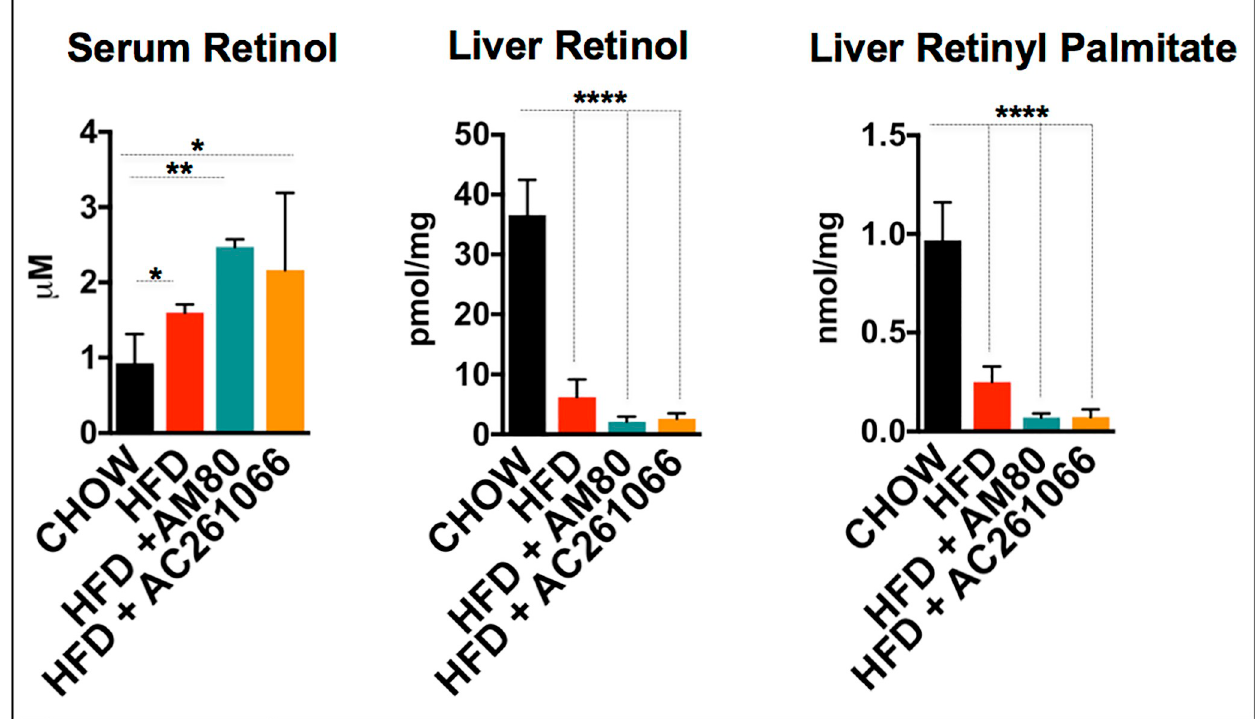
Fig 2. Retinol (ROL) is increased in serum, and retinol and retinyl palmitate are decreased in HFD-, HFD+AM80- and HFD+AC261066-treated compared to chow-fed mice. Quantitation by HPLC of serum retinol, liver retinol, and liver retinyl palmitate in chow-, HFD-, HFD+AM80-, and HFD +AC261066-treated mice. The plots are represented as mean ± standard deviation (SD). Mice per group = 4; Black stars represent statistical significance according to the one-way ANOVA test, p < 0.05 = � ; p < 0.01 = �� ; p < 0.001 = ��� ; p < 0.0001 = ���� .